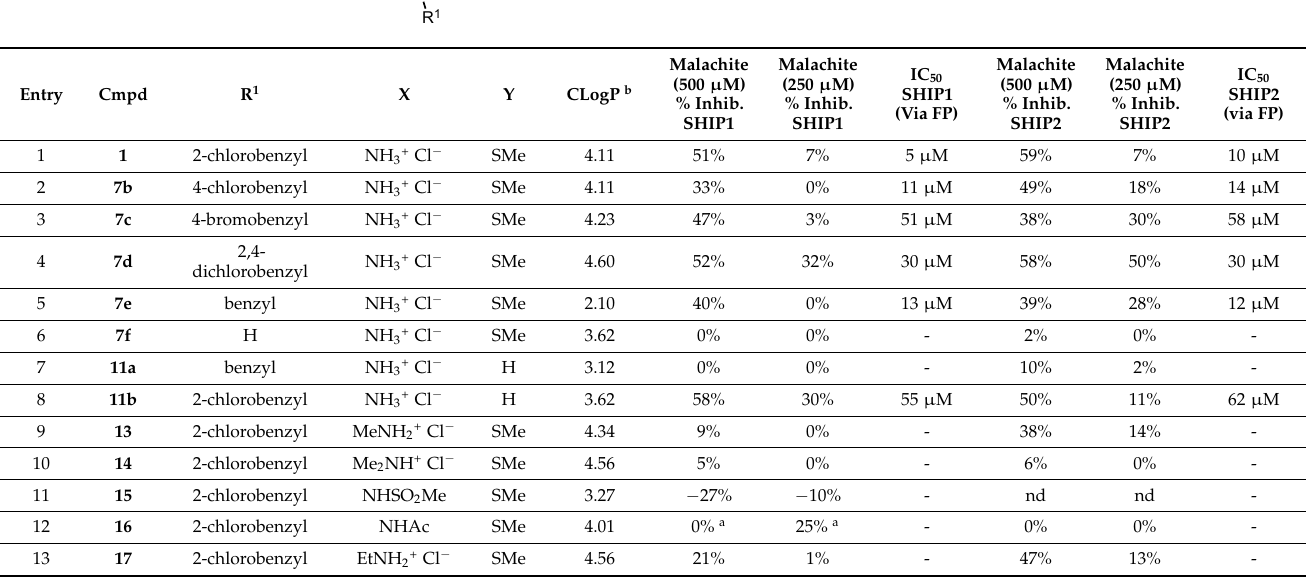
Table 1. In Vitro Evaluation of Tryptamines.